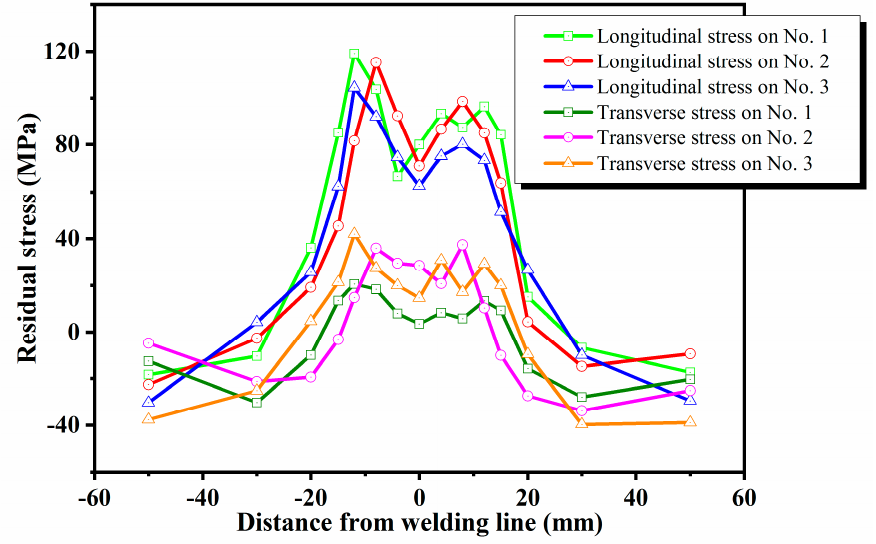
Figure 4. Residual stress distribution on the surface.